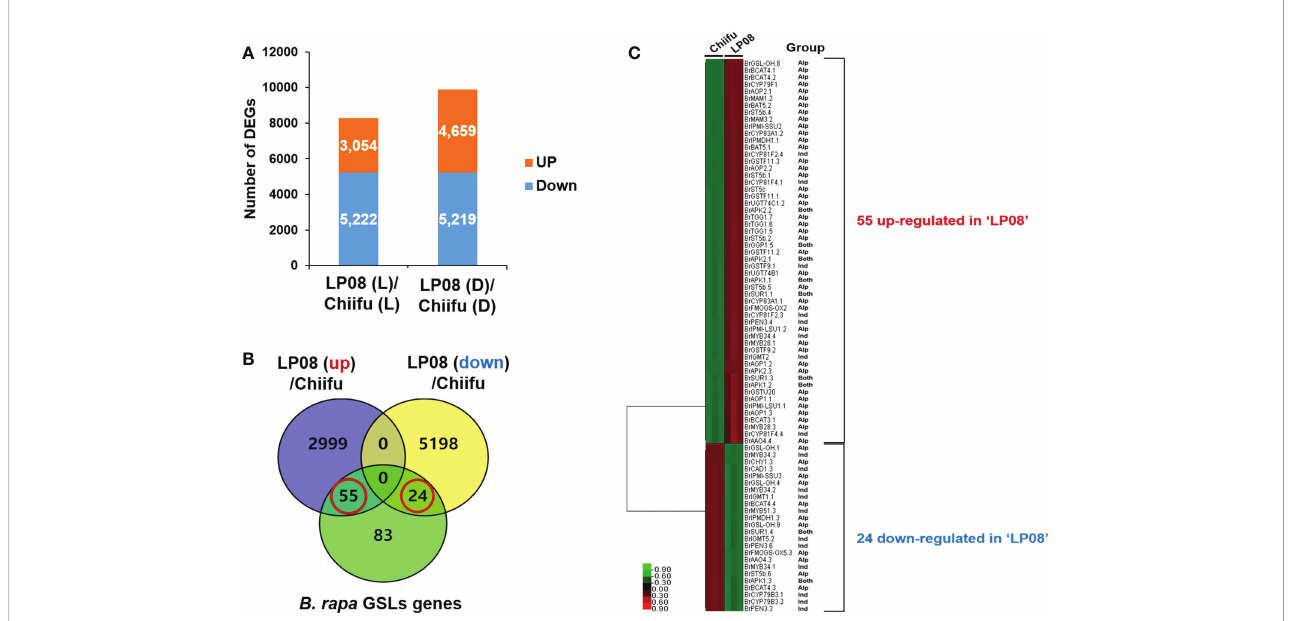
FIGURE 2 Identi fi cation of differentially expressed genes (DEGs) between ‘ Chiifu ’ and ‘ LP08 ’ under light and dark conditions. (A) Bar graph showing the number of differentially expressed genes revealed by pairwise comparison between ‘ Chiifu ’ and ‘ LP08 ’ grown under light (L) or dark (D) conditions. (B) Venn diagram showing 79 GSL pathway genes found among the 3,054 up-regulated and 5,222 down-regulated genes in ‘ LP08 ’ . Out of these 79 genes, 55 and 24 were up- and down-regulated, respectively, in ‘ LP08 ’ compared to ‘ Chiifu ’ . (C) Heatmap of 79 GSL pathway DEGs between ‘ Chiifu ’ and ‘ LP08 ’ . Alp: aliphatic GSL pathway, Ind: indolic GSL